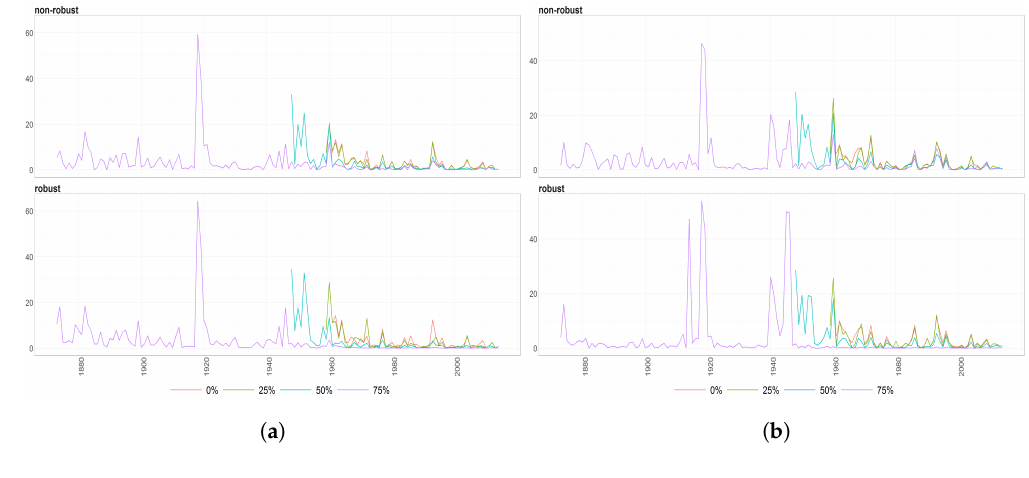
Figure 11. The Mahalanobias distances obtained using PPCA for Females ( a ) and Males ( b ) of Life Expectancy at Birth over time (x axis). Different colours of lines correspond to the cases of different percentages of maximal missing entries in rows (light blue (75%), dark brown (50%), dark blue (25%), light brown (0%)). Every subfigure is divided into two subplots corresponding to the robust estimation of standard divinations (upper plot) and sample one (bottom plot).